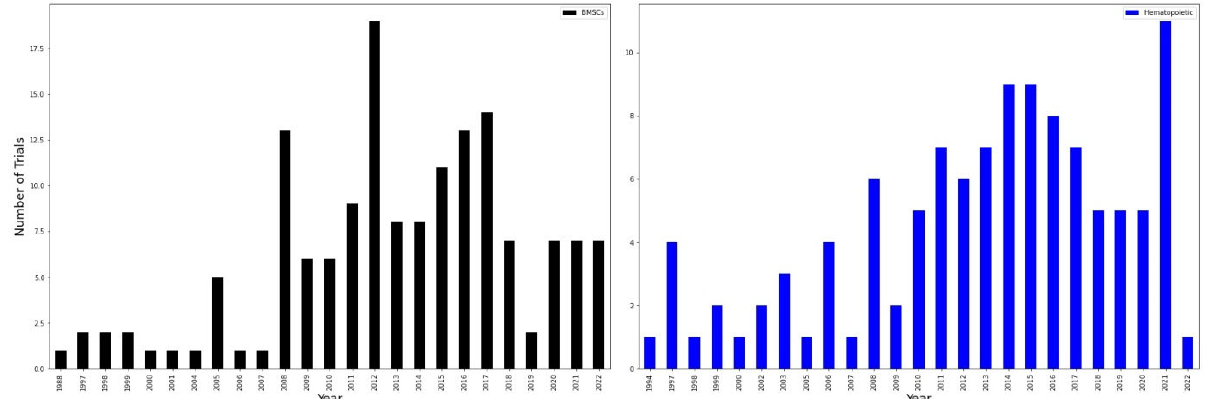
Figure 6. BMSCs and hematopoietic stem cells clinical trials. On the left (black) is a graph for BMSCs and on the right (blue) for hematopoietic stem cells.